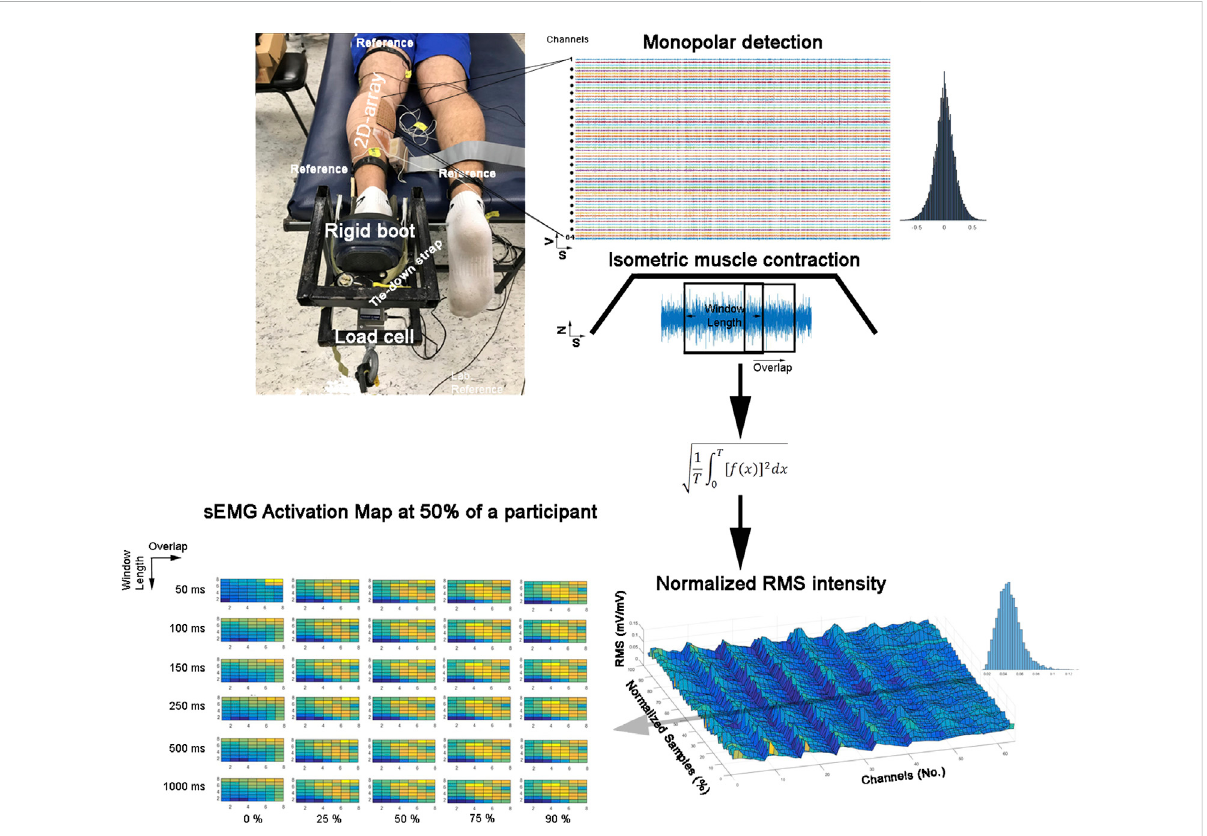
FIGURE 1 Experimental set-up and instantaneous surface electromyographic map generation fl ow. Colors represent the instantaneous potential amplitude distribution (yellow indicates more intensity, and blue indicates lower